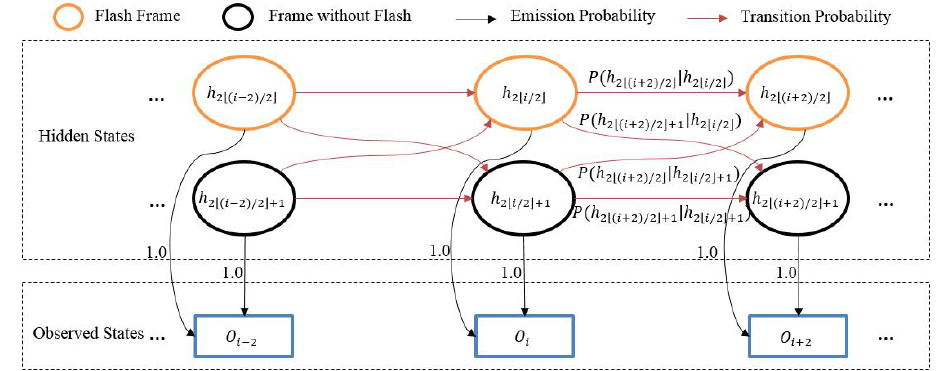
Figure 15. Hidden Markov Model for matching sequences, and the O values of the flash